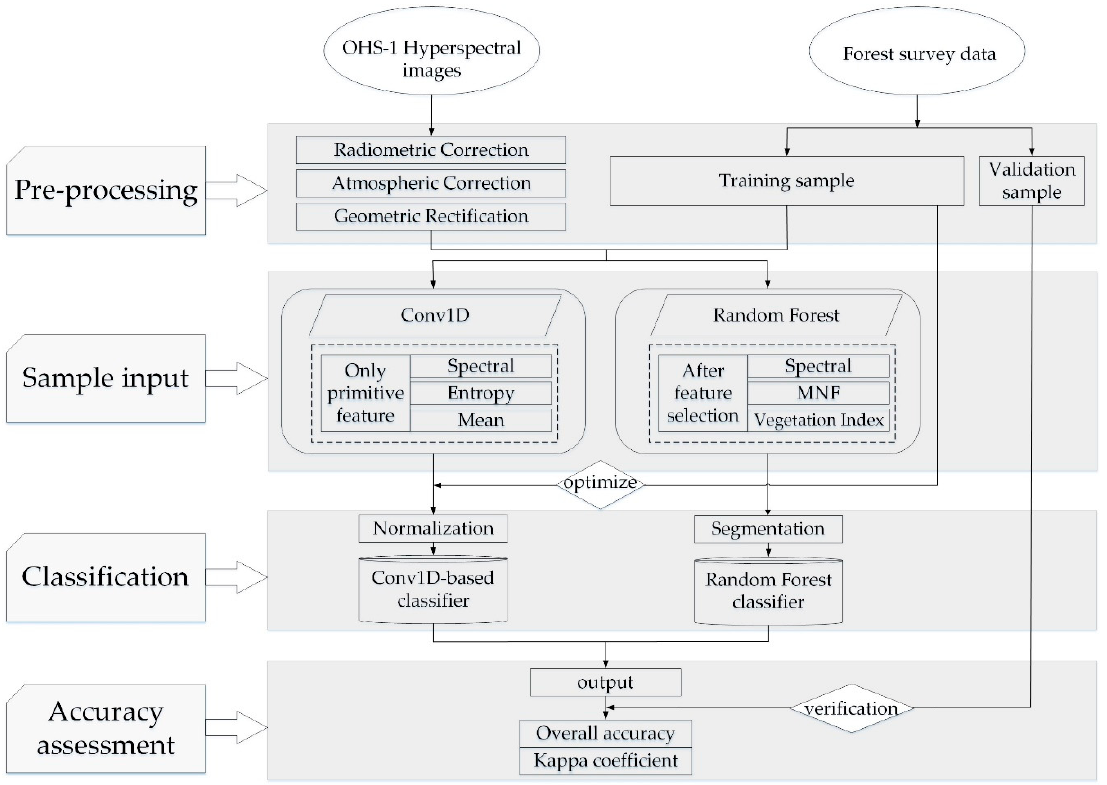
Figure 2. Framework of the tree species classification based on one-dimensional convolutional neural network (Conv1D) and random forest classifier.